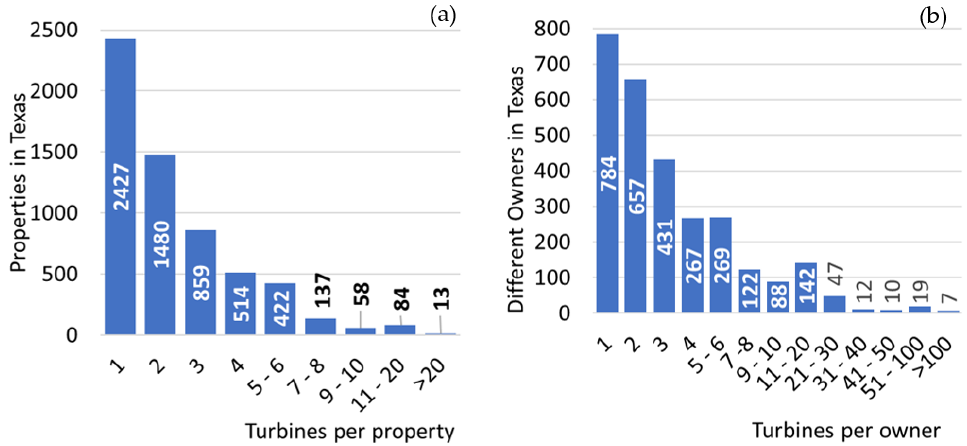
Figure 13. Assessment on the number wind turbine installed on individual lots in Texas classified according to ( a ) distinctive lots on which the number of wind turbines indicated in the x -axis are installed and ( b ) the number of different owners in Texas that have the number of wind turbines indicated in the x -axis installed in their plots. indicated in the x -axis installed in their